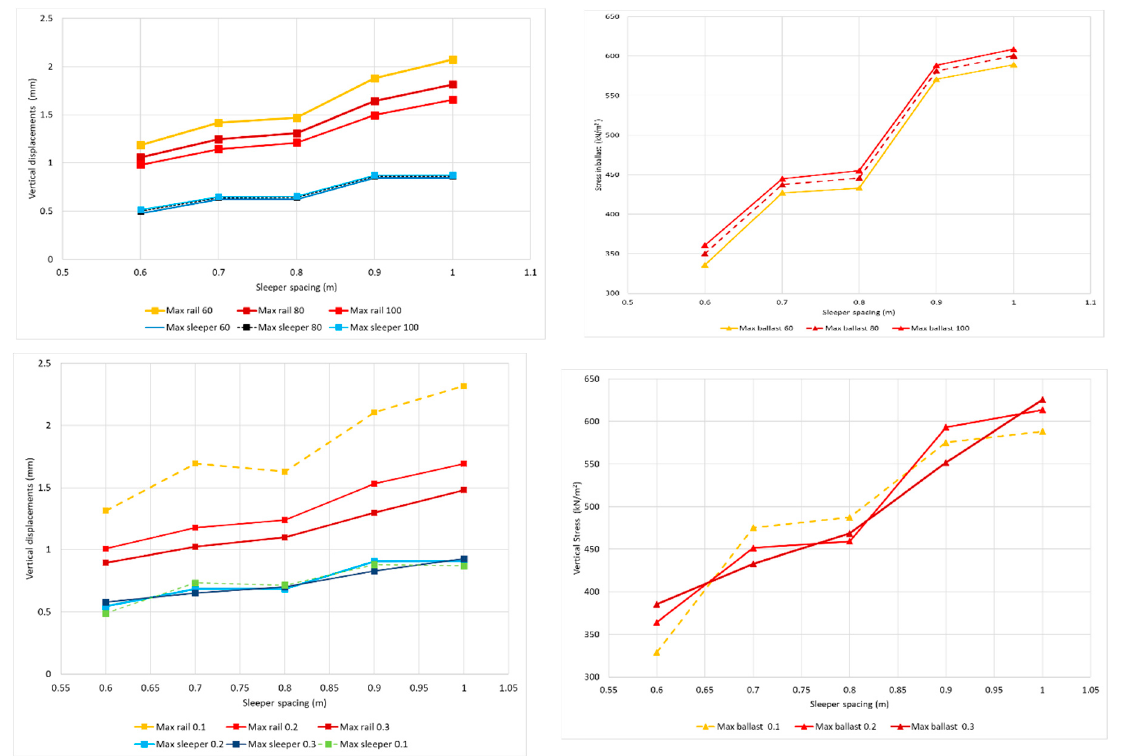
Figure 9. Case study with different pad materials ( up ) and different geometry ( down ). Table 7. Maximum values and allowed values to the analysed variables according to